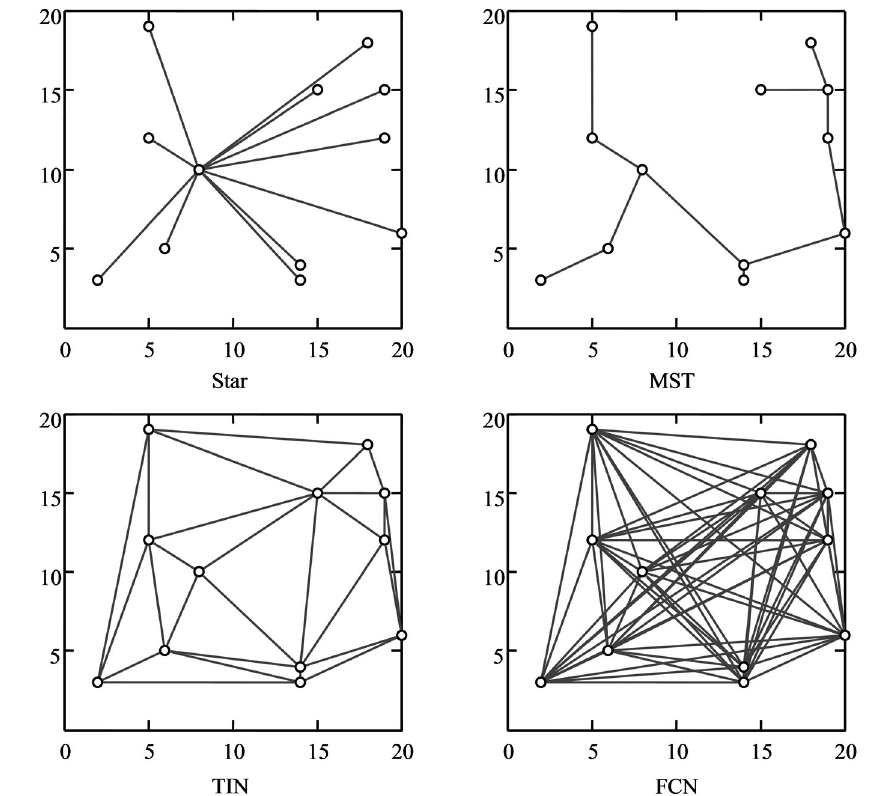
Figure 1. Several typical PS networks used elsewhere, including star network, minimum spanning tree (MST) network, triangular irregular network (TIN), and freely connected network